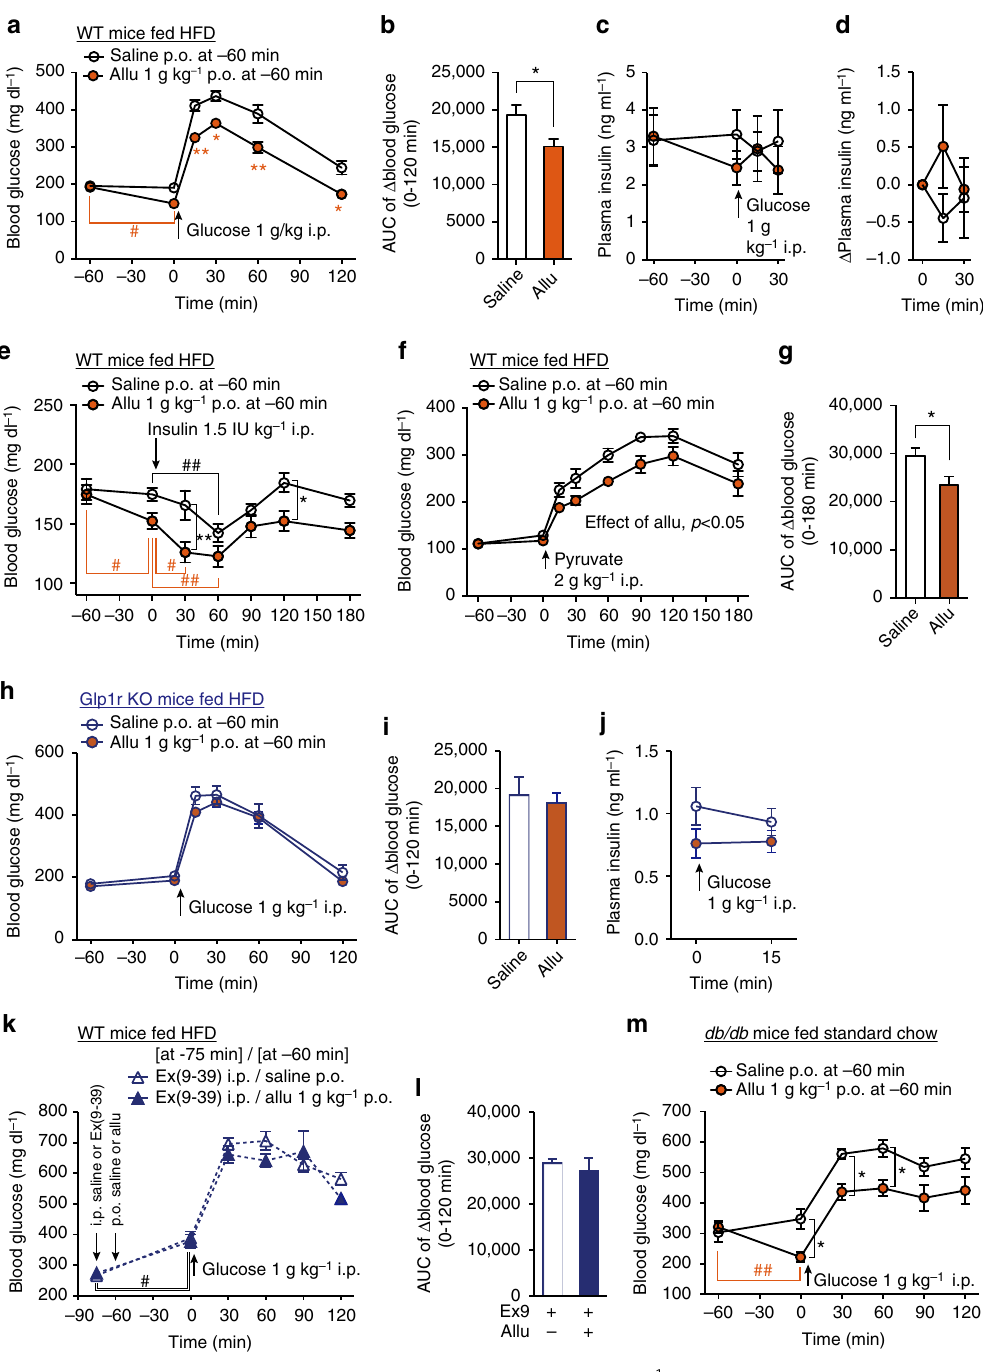
Fig. 5 D -Allulose improves glucose tolerance via GLP-1R in obese and diabetic mice. Allu at 1 g kg − 1 or saline was p.o. administered at 60 min prior to ipGTT (1 g kg − 1 , a – d , h – m ), ITT (1.5 IU kg − 1 , e ), and PTT (2 g kg − 1 , f , g ) in HFD-fed obese C57BL/6J mice (WT), HFD-fed Glp1r KO mice or standard chow-fed diabetic db/db mice. a – d Blood glucose ( a ) and plasma insulin levels ( c ) after p.o. injection of Allu at − 60 min and during ipGTT in HFD-fed obese and hyperglycemic C57BL/6J mice fasted for 4 h. b AUC for rise of blood glucose during 0 – 120 min. d Change of plasma insulin levels after ipGTT plotted from c . n = 6 – 10. e Blood glucose levels after p.o. Allu at − 60 min and during ITT in HFD-fed mice fasted for 4 h. n = 6 – 7. f , g Blood glucose level and its AUC during 0 – 180 min in PTT in HFD-fed mice fasted overnight. n = 6 – 7. h – j In HFD-fed Glp1r KO mice fasted 4 h, blood glucose level ( h ) and its AUC ( i ) and plasma insulin levels ( j ) after p.o. administration of Allu and during ipGTT. n = 6. k , i Effect of 600 nmol kg − 1 Ex(9-39) administered at − 75 min on blood glucose level ( k ) and its AUC ( i ) in GTT in HFD-fed C57BL/6J mice fasted 4 h. m Blood glucose levels after p.o. Allu at − 60 min and during ipGTT in db/db mice fasted for 4 h. n = 5. In a , e , m , * p < 0.05, ** p < 0.01 by two-way ANOVA followed by Bonferroni ’ s test vs. saline group. In a , e , k , m , # p < 0.05, ## p < 0.01 by two-way ANOVA followed by Dunnett ’ s test vs. 0 min in each group. In f , effect of Allu treatment was signi fi cant with p < 0.05 by two-way ANOVA. * p < 0.05 by unpaired t -test ( b , g ). Error bars are